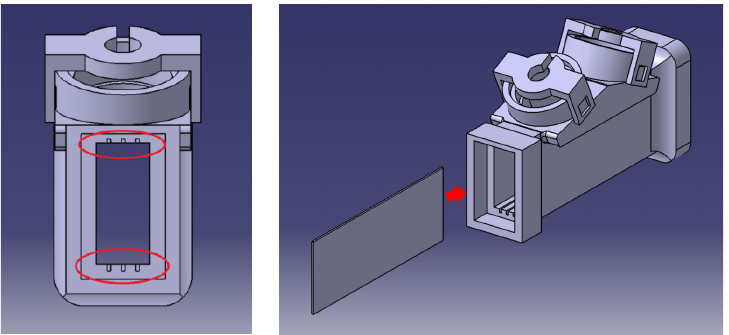
Figure 4. Installation of the metallic plates.